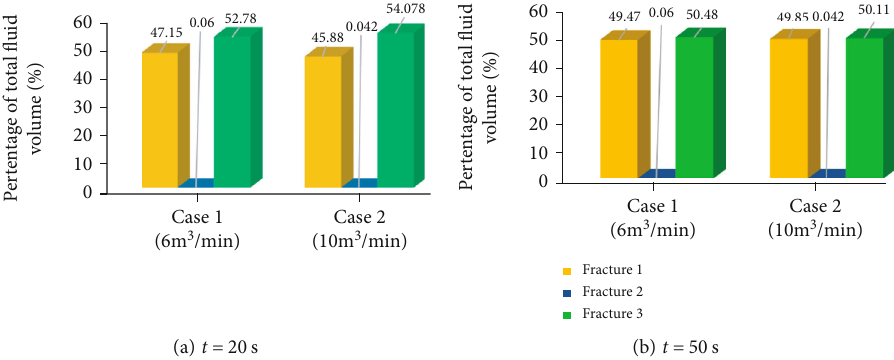
Figure 9: The total fl uid volume distribution of each cluster after pumping for 20s and 50 s for two di ff erent fl ow rates.